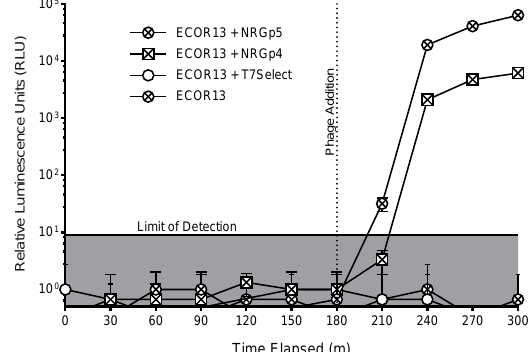
Figure 3. Luminescence was measured from E. coli samples with and without the phages of T7 Select, which did not contain a gene for a reporter enzyme, NRGp4, but which contained a gene for NanoLuc-CBM, and NRGp5, which contained an optimized NanoLuc-CBM gene. It can be seen that the reporter genes resulted in luminescence with the optimized gene providing a higher signal. Error bars indicate the standard deviation of three biological triplicates and the limit of detection (lowest positive signal) was calculated as the negative control + 3x the standard deviation. The standard deviation for phages NRGp4 and NRGp5 was too low to produce visible error bars at the final time points of the